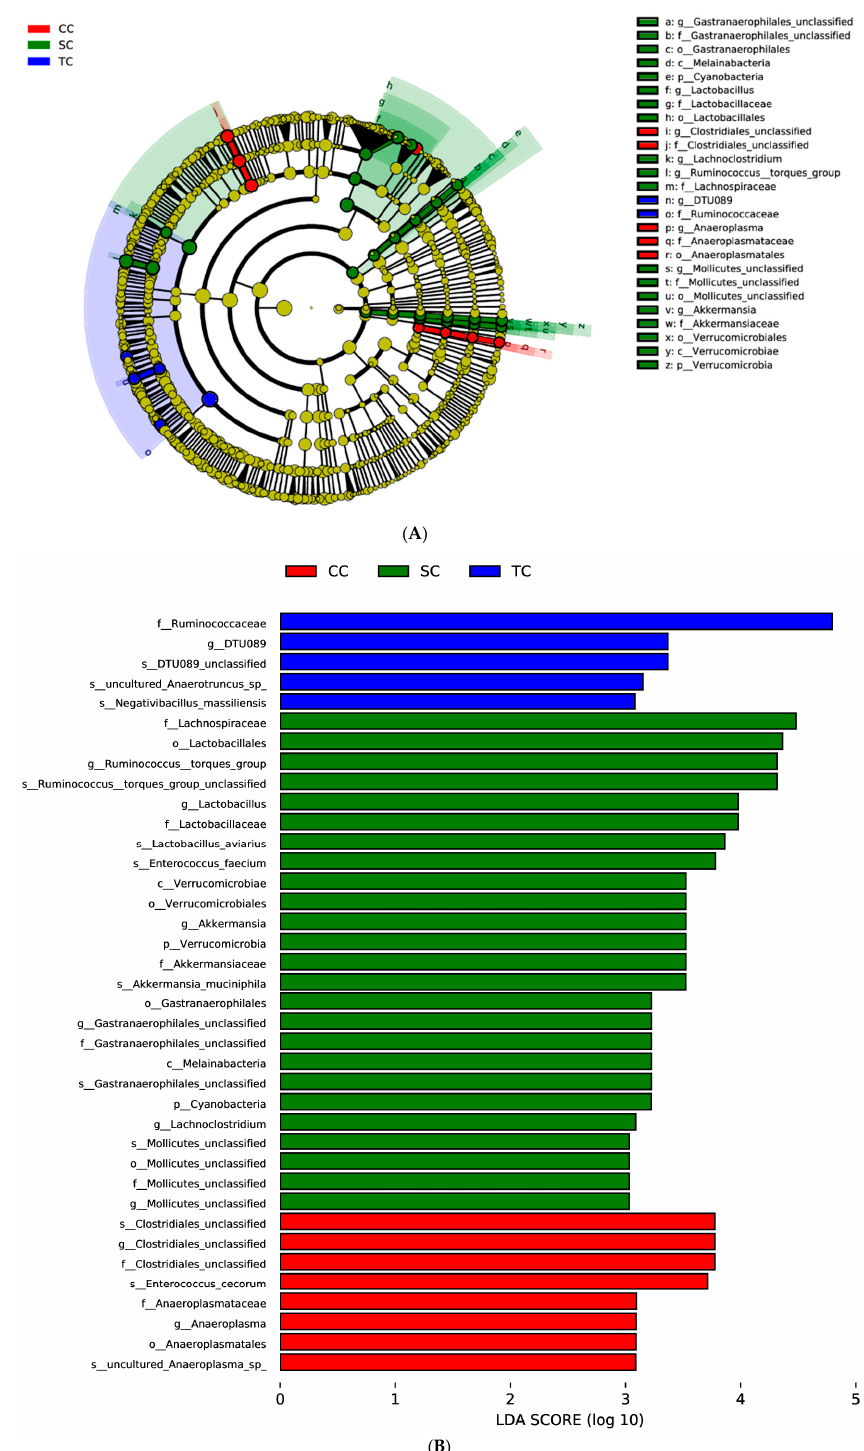
Figure 4. Linear discrimination analysis (LDA) coupled with effect size (LEfSe) analysis of the cecal microbial community of broilers in the CC, SC, and TC groups. ( A ) Cladogram showing microbial species with significant differences among the three treatment groups. Red, green, and blue represent different groups. Species classification at the phylum, class, order, family, and genus levels are displayed from inner to outer layers. The red, green, and blue nodes represent microbial species in the phylogenetic tree that play important roles in the CC, SC, and TC groups, respectively. Yellow nodes represent no significant difference between species. ( B ) Significantly different species with an LDA score greater than the estimated value (default score = 3). The length of the histogram represents the LDA score of different species in the three groups. CC, control group; SC, 25% of soybean meal (SBM) replaced with fermented SBM (FSBM); TC, 50% of SBM replaced with FSBM.